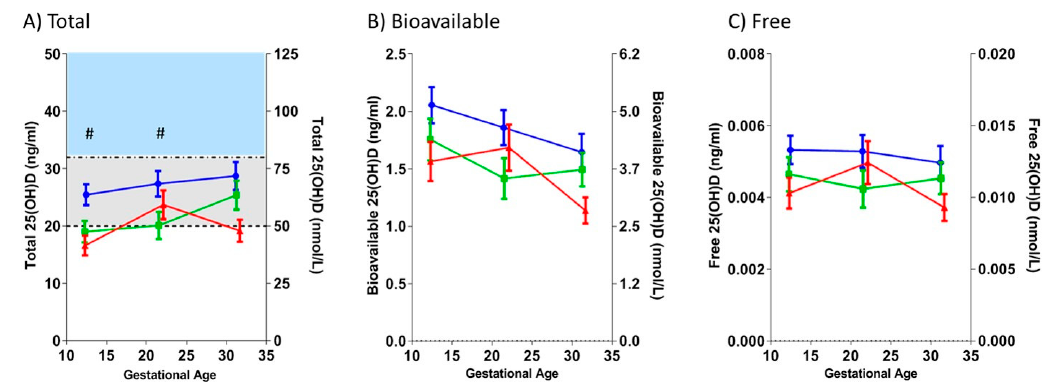
Figure 1. Maternal concentrations of total, bioavailable, and free 25-hydroxyvitamin D (25(OH)D), according to type 1 diabetes (T1DM) and/or preeclampsia (PE) status. Longitudinal changes in ( A ) total, ( B ) bioavailable, and ( C ) free 25(OH)D concentrations, prior to the clinical onset of PE. Values (mean ± SEM) are plotted against the three study visits, corresponding to ~12, ~22, and ~32 gestational weeks, respectively. Red: women with T1DM who subsequently developed PE (DM+PE+); green: women with T1DM who did not develop PE (DM+PE-); blue: non-diabetic, normotensive women (DM-). # p < 0.05 for DM+PE- vs. DM-. Cut points for Total 25(OH)D: Normal: > 32 ng/mL ( shaded blue ), Insufficient: ≥ 20 and ≤ 32 ng/mL ( shaded grey ), Deficient: < 20 ng/mL.